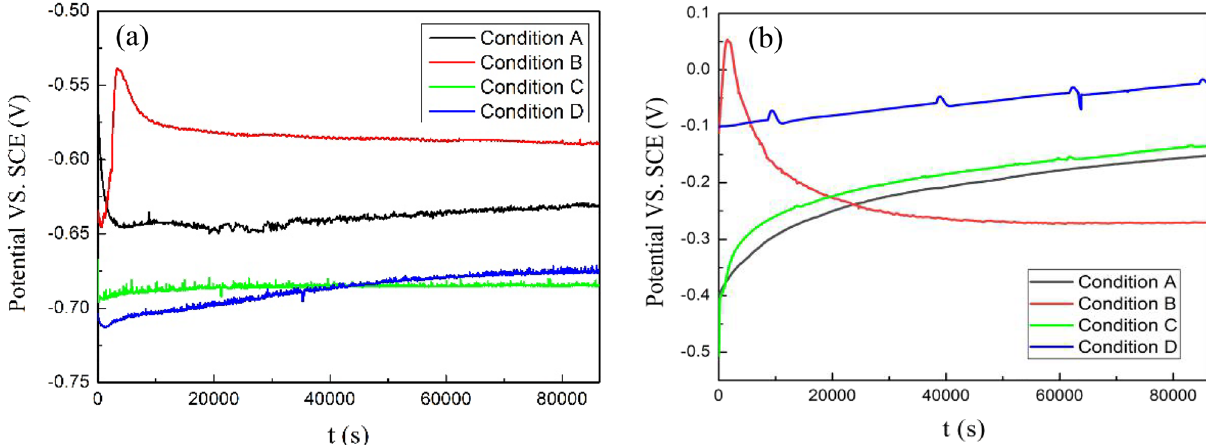
Figure 1. OCP evolution with immersion time for different titanium alloy samples under test conditions: ( a ) Ti-6Al-4V and ( b )